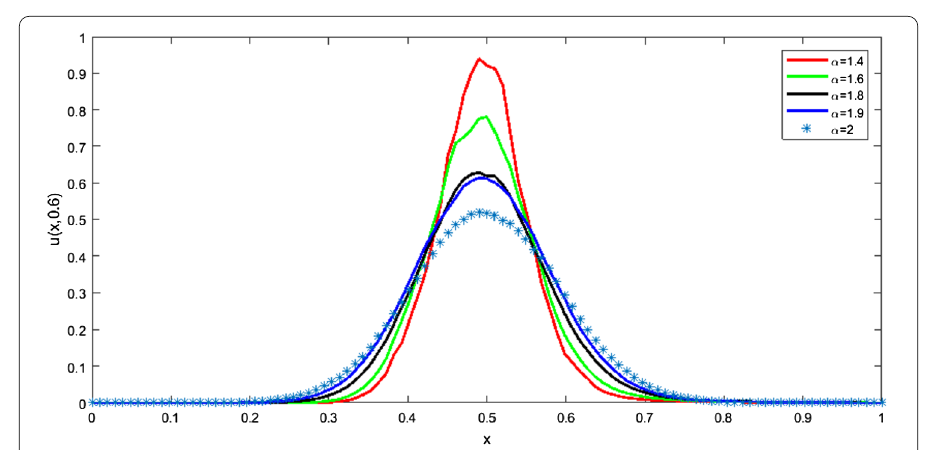
Figure 3 Mean solutions of SFDE using